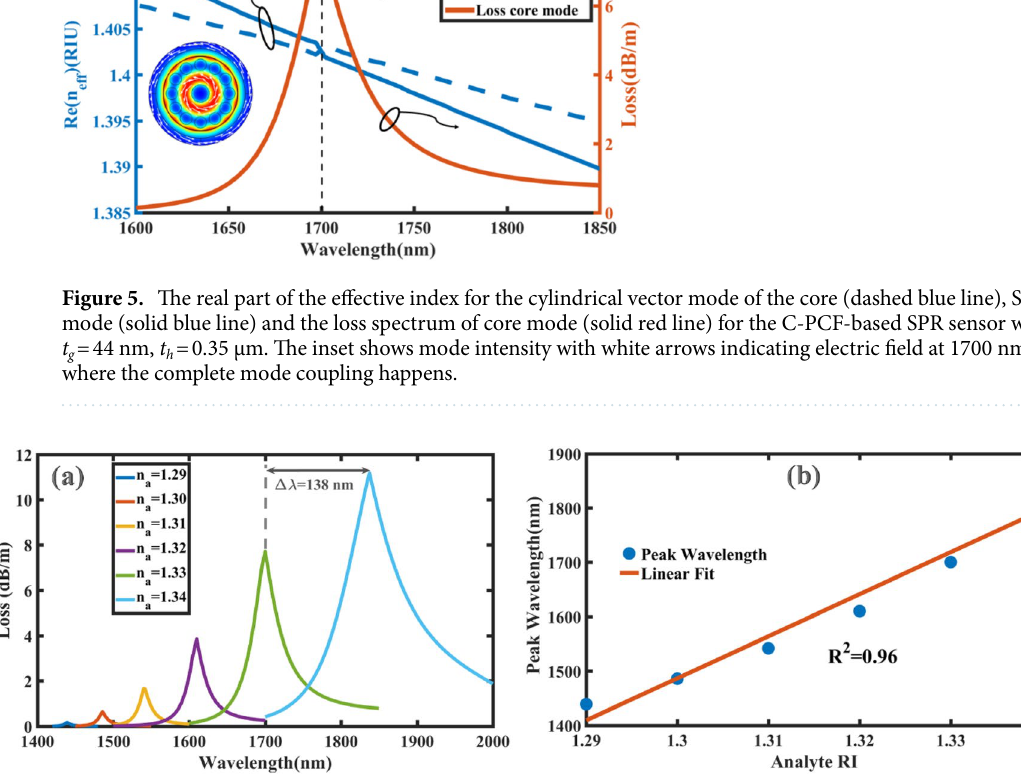
Figure 6. ( a ) Loss spectra for various analyte RI ( n a ) ranging from 1.29 to 1.34 by step size of 0.01; and ( b ) linear fit (red line) for peak wavelengths (blue points) versus analyte